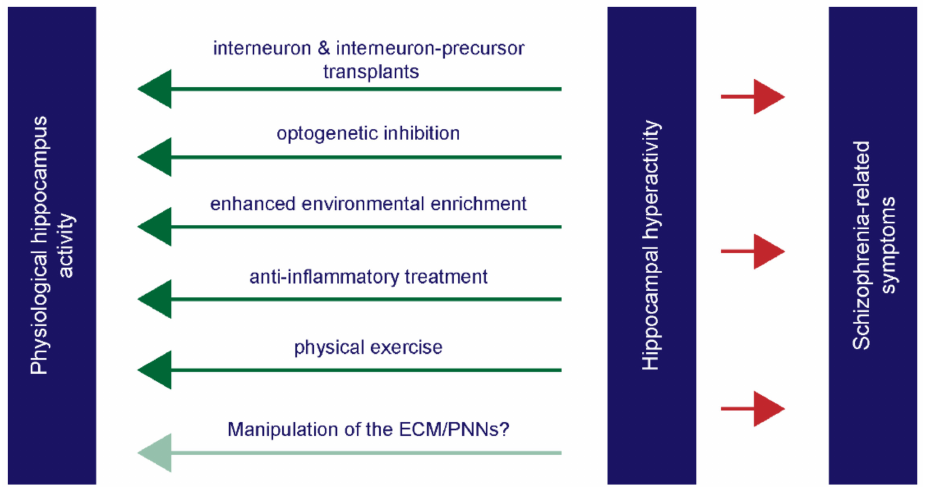
Figure 4. The intervening strategies that enhance hippocampal deviations in animal models for schizophrenia. Several studies targeted the hippocampus in schizophrenia animal models and ob- served ameliorating effects induced by different experimental approaches. Here, the transplantation of interneuron and interneuron-precursor transplants resulted in a reduction of the hippocampal hyperactivity [266–268]. Additionally, a reduction of the increased hippocampal activity could be achieved using optogenetic techniques [248]. Physical exercise [265], as well as an enhanced en- vironmental enrichment [216,271,272] during the experimental procedures showed beneficial and protecting effects regarding the hippocampal activity. In maternal immune activation models for schizophrenia, a treatment with anti-inflammatory agents enhanced hippocampal parameters in the offspring [270]. Lastly, a manipulation of the extracellular matrix, especially of the interneuron- surrounding perineuronal nets, could be another possible approach for schizophrenia since this neuronal subtype shows disruptions in patients and goes along with impaired